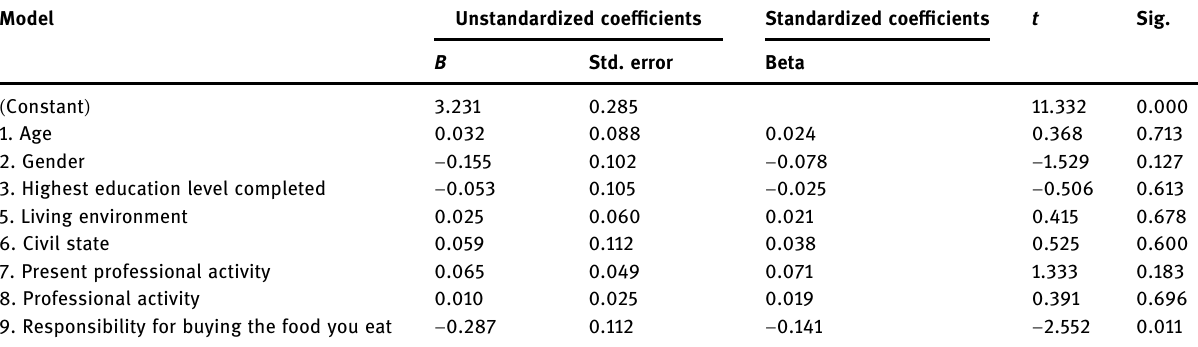
Table 16: Coe ffi cients for model two ( dependent variable: healthy diet behavior and attitude )